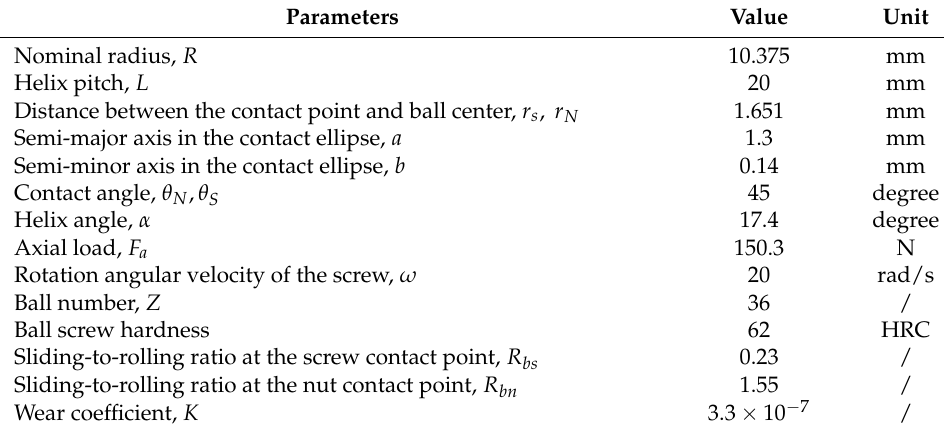
Table 7. Initial parameters of the ball screw.